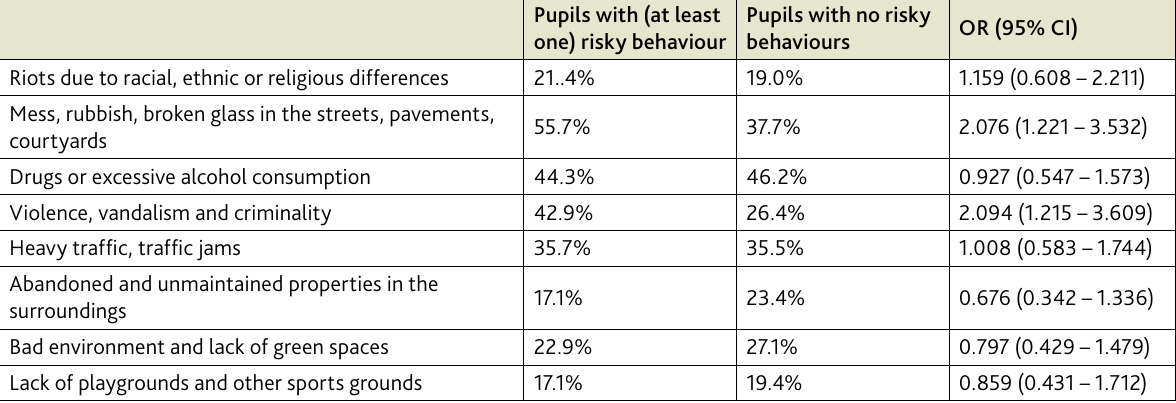
Table 7. Percentage of respondents who answered that they consider the following facts in the surroundings of their schools as highly or very